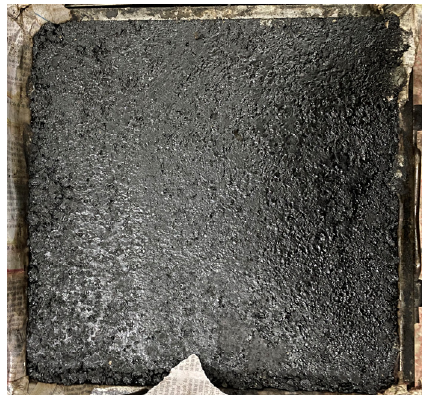
Figure 3. Specimen of the wheel tracking test.